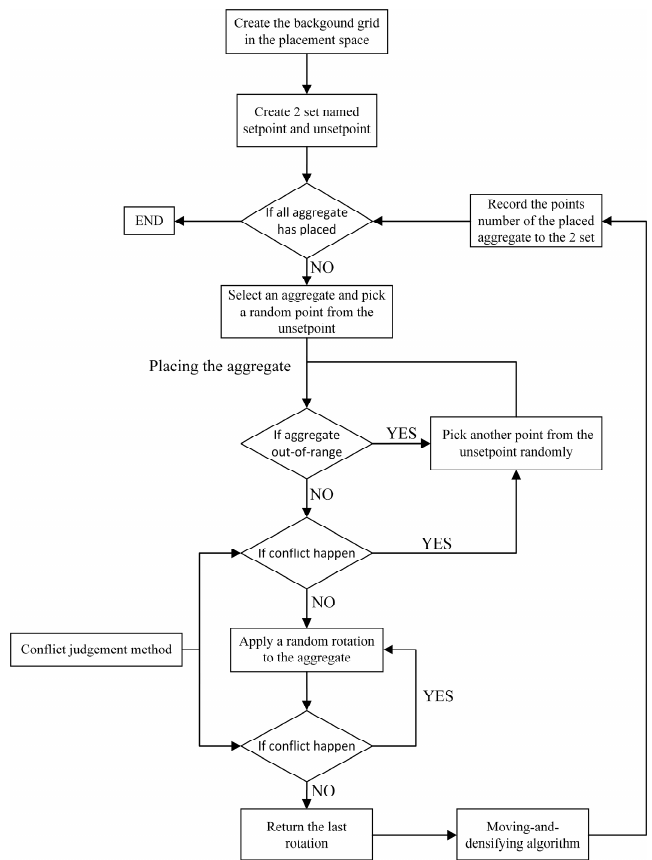
Figure 3. The fl owchart of the packing process. Figure 3. The flowchart of the packing